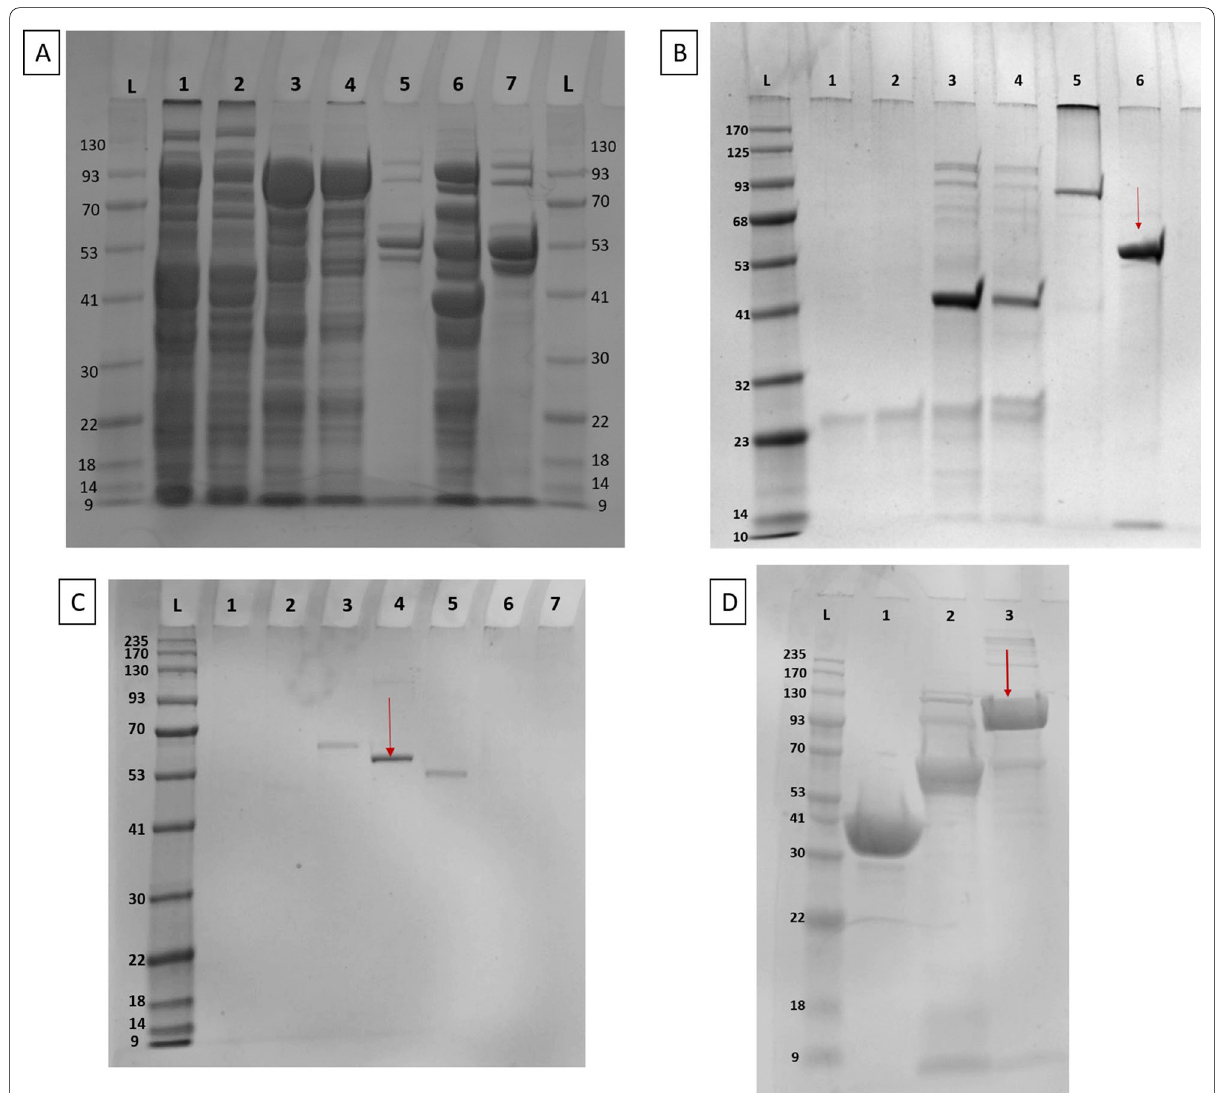
Fig. 1 SDS‑PAGE of TFP‑Gp17. A Samples from all purification steps by nickel‑affinity chromatography. Lanes: 1, supernatant from bacterial lysate; 2, flow through 1 (FT1) containing the unbound proteins; 3, elution fraction 1 (elution with buffer A supplemented with 250 mM imidazole); 4, elution fraction after desalting with ammonium sulfate; 5,7, FT2, containing the unbound proteins after cleavage with the TEV protease; 6, elution fraction 2. B TFP‑Gp17 before SEC chromatography is shown in the lane 6. C Protein fractions after SEC chromatography; TFP‑Gp17 in 4 lane is indicated by the red arrow. D The H/MTFP‑Gp17 protein after SEC chromatography is indicated in lane by the red